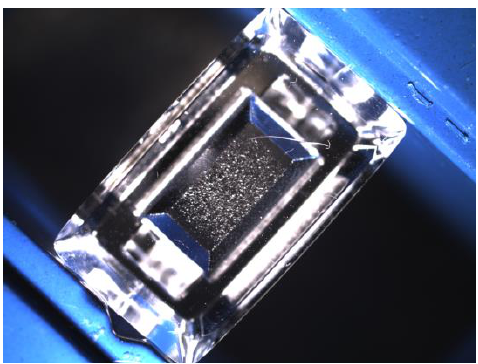
Figure 1. A transparent illuminant component with a defect (scratch).